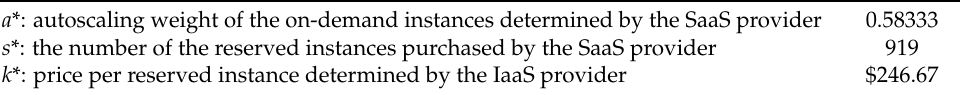
Table 3. Decision Variables and Their Optimal